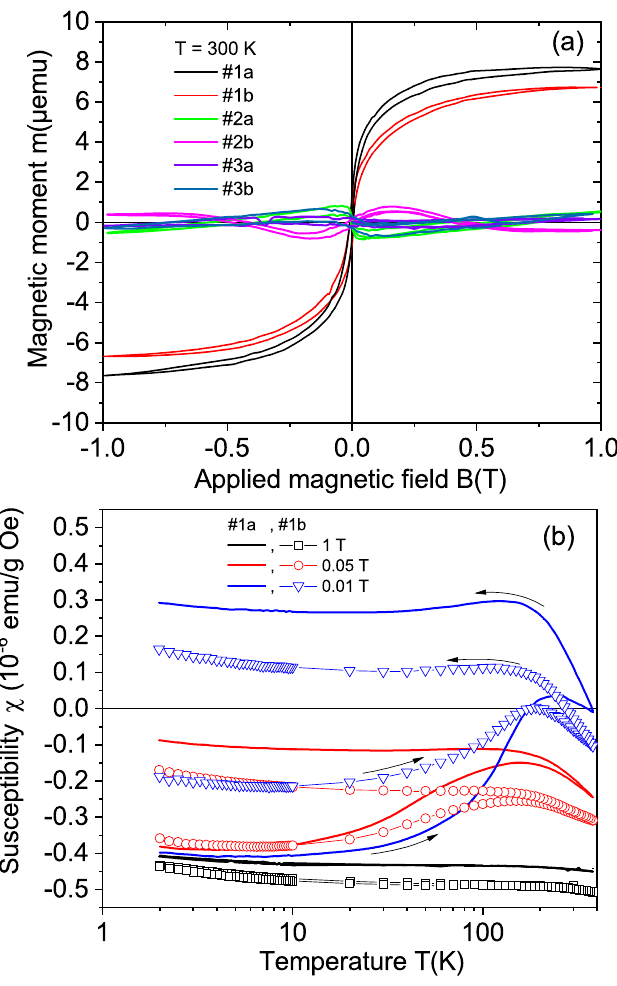
Figure 6. ( a ) Field hysteresis loops of the magnetic moment of all CVD samples at 300 K. The diamag- netic background was subtracted from the measured data. We note that the field loops obtained for some of the CVD samples were influenced by the hysteresis of the superconducting solenoid. This is a systematic error of the SQUID system that can influence the hysteresis loops. ( b ) The susceptibility as a function of temperature at constant fields in the zero-field-cooled (measurement by warming the sample after applying the corresponding fields at the lowest temperature) and field-cooled (measure- ment by cooling the sample at the same field) states of the two samples (#1a, continuous lines; #1b, symbols). No background was subtracted from the data. The mass used to calculate the susceptibility was the total sample mass, which was similar in both